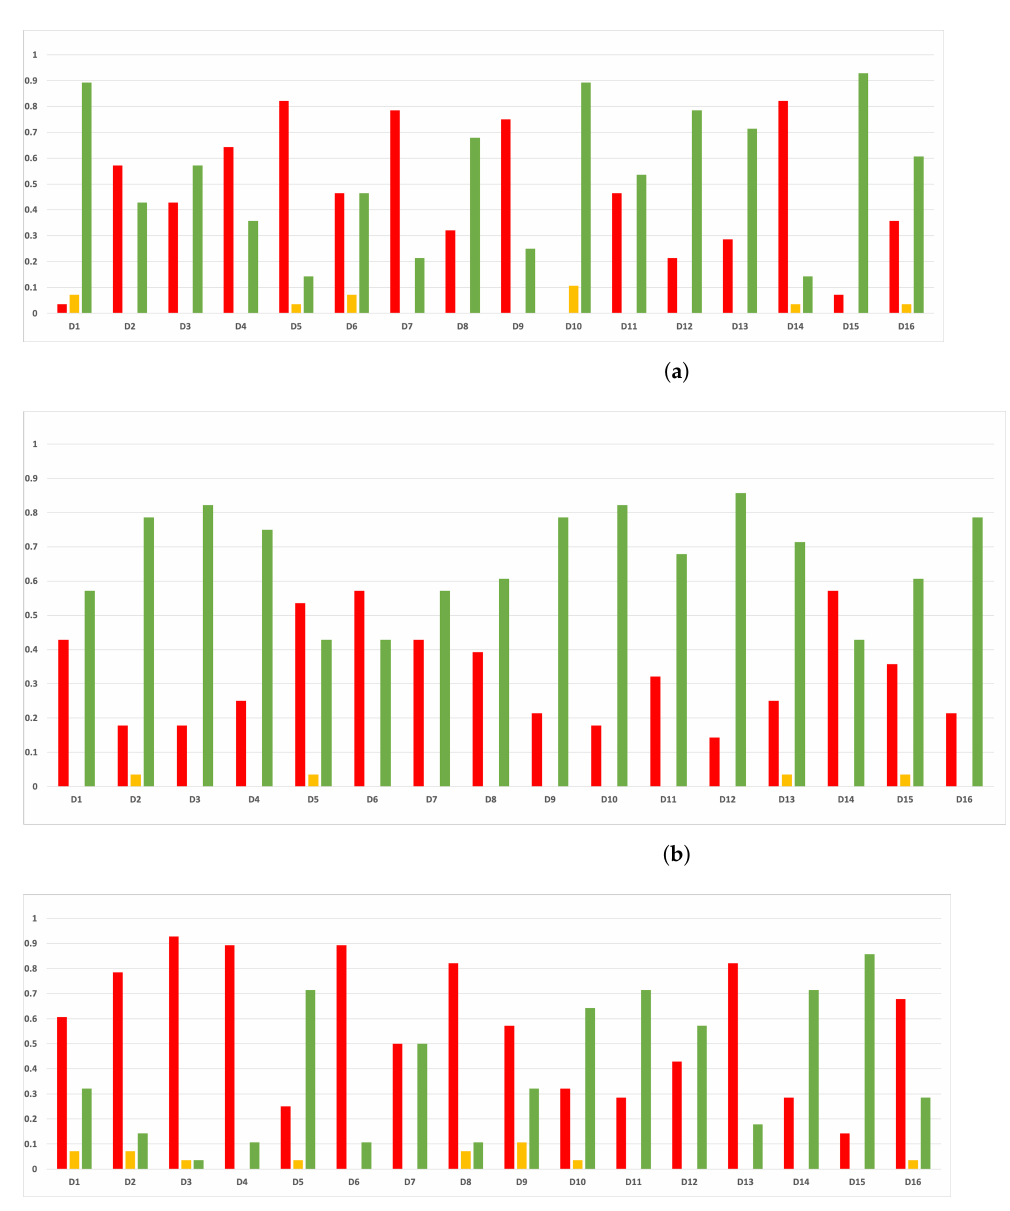
Figure 23. Experiment 2: consistency per dataset. Rate of validity with the MCC and time complexity. ( a ) Rate of validity per dataset in RF. In axis X, the dataset. In axis Y, the rate of RHOASo for each class of validity. ( b ) Rate of validity per dataset in GB. In axis X, the dataset. In axis Y, the rate of RHOASo for each class of validity. ( c ) Rate of validity per dataset in MLP. In axis X, the dataset. In axis Y, the rate of RHOASo for each class of